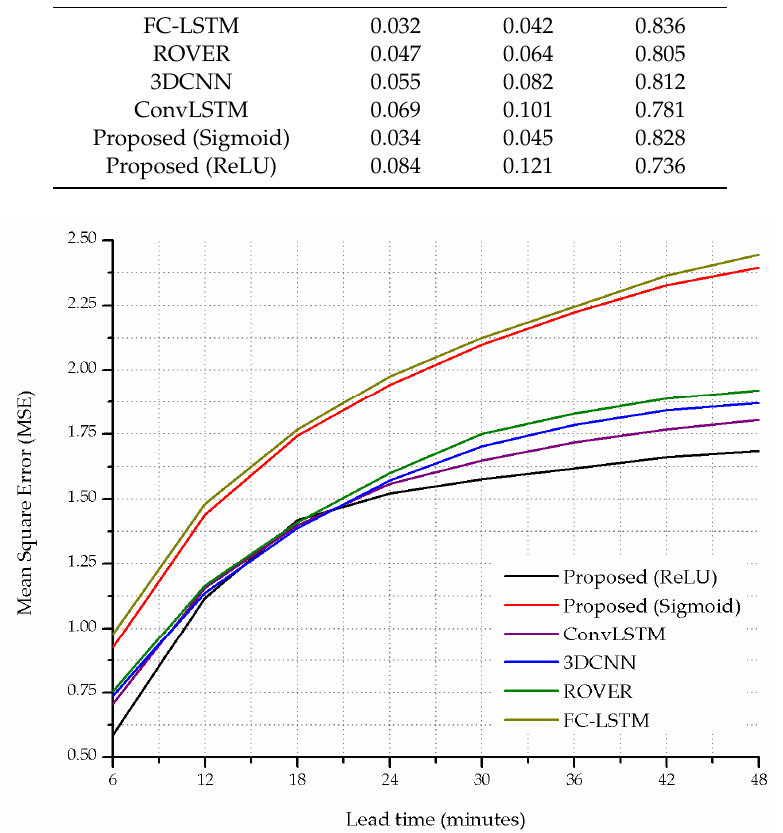
Figure 6. Mean square error comparison of different models.